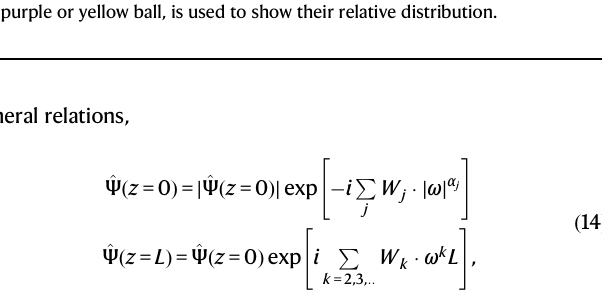
phase( “ Frac.phase ” )termsinthe fi rstlineofEq.(14),whicharegeneratedbyinput- (cid:1) (cid:3) = ð 0 : 4,0 : 73 Þ , (0.6,0.07), (0.8,0.51), and phase terms with parameters α j , W j (1.0,0.22), respectively. The horizontal axis in each panel represents the set of valuesofLI α j =0.4,0.6,0.8,1,and2,respectively;theverticalaxisrepresentsvalues of the relative weight W j from 0 to 0.7. Yellow balls denote the relative weights of thesecond-orderregularphase( “ Reg.phase ” )term W k =2 .Thesolidline,connecting the purple or yellow ball, is used to show their relative